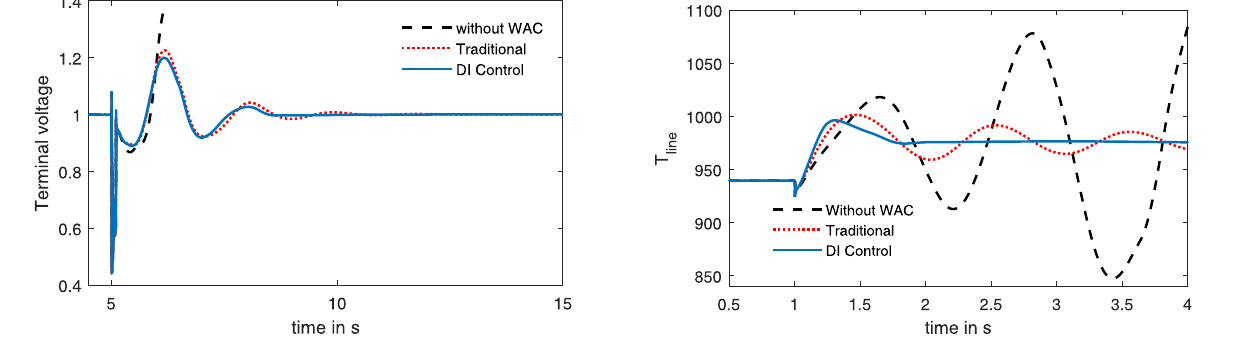
Fig. 9 Terminal voltage in the worst fault scenario